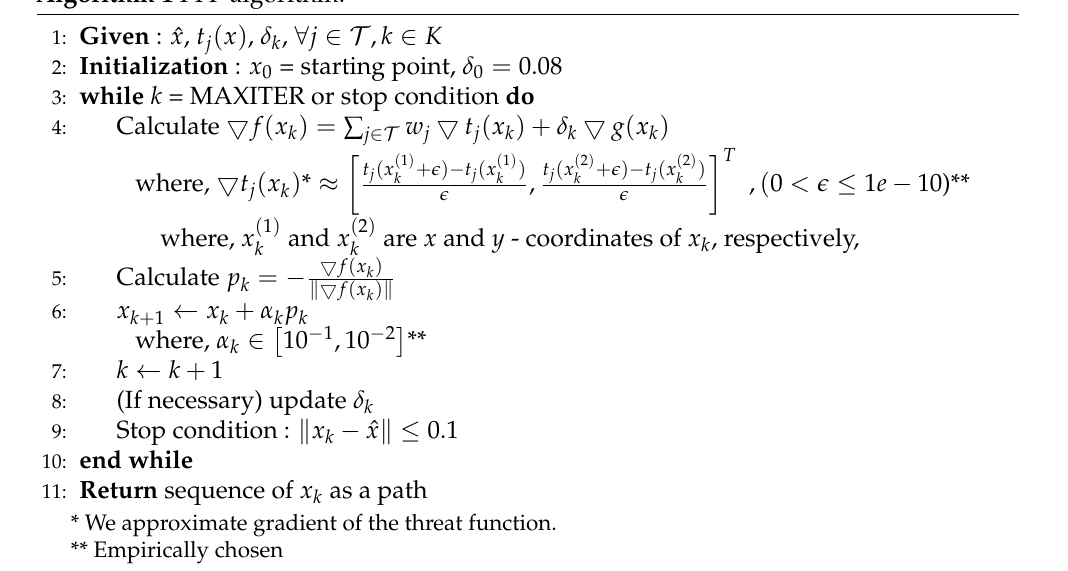
Algorithm 1 PFP